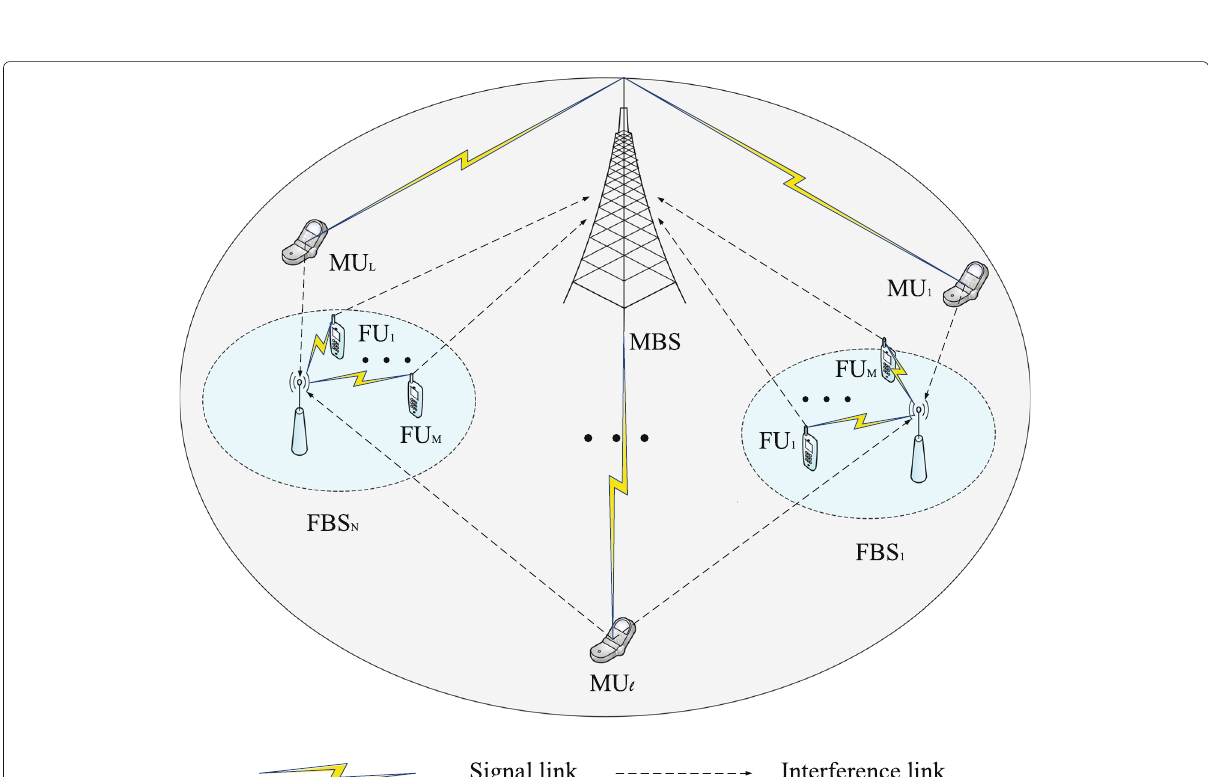
Fig. 1 System model. Signal link and interference